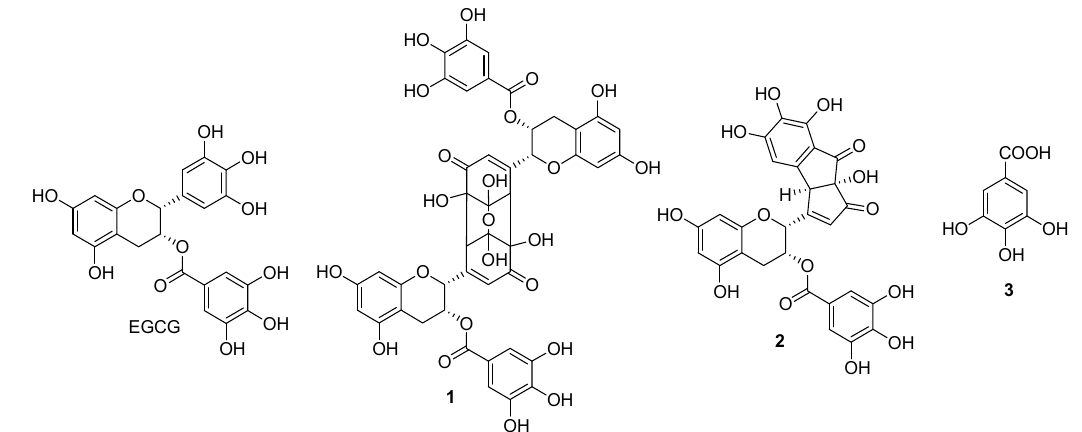
Figure 1. Chemical structures of oxidation products 1 − 3 of EGCG: 1 , EGCG quinone dimer A; 2 , theacitrinin A; 3 , gallic acid.